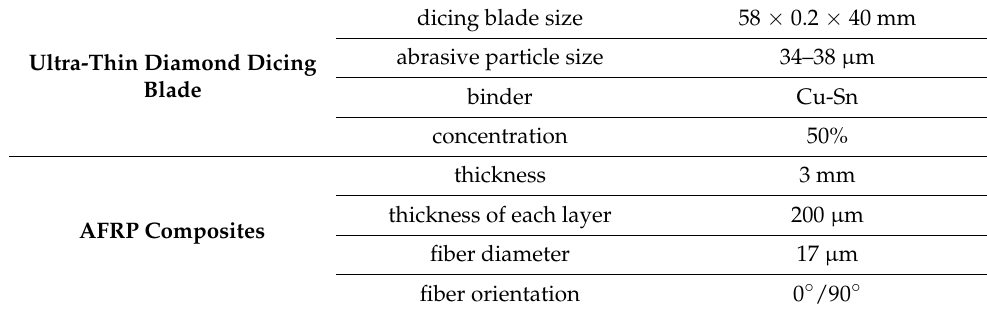
Table 1. The parameters of aramid fiber-reinforced plastic (AFRP) composites and dicing blade.